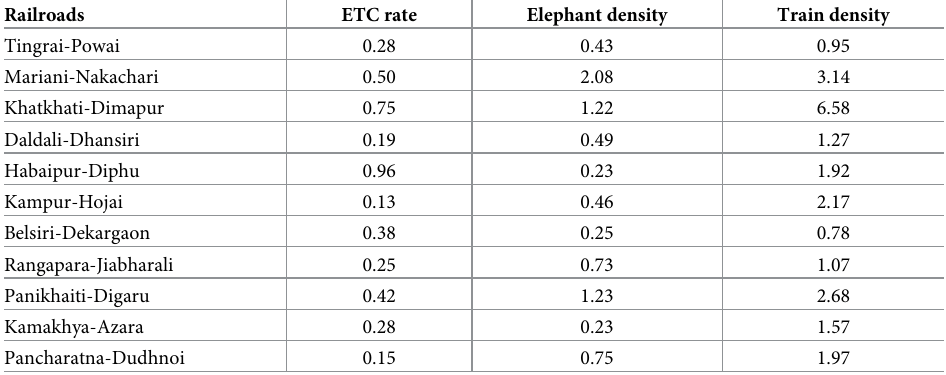
Table 9. Spatial variation of ETC rates and densities of elephants and trains in the grid cells of the prioritized railroads. Railroads ETC rate Elephant